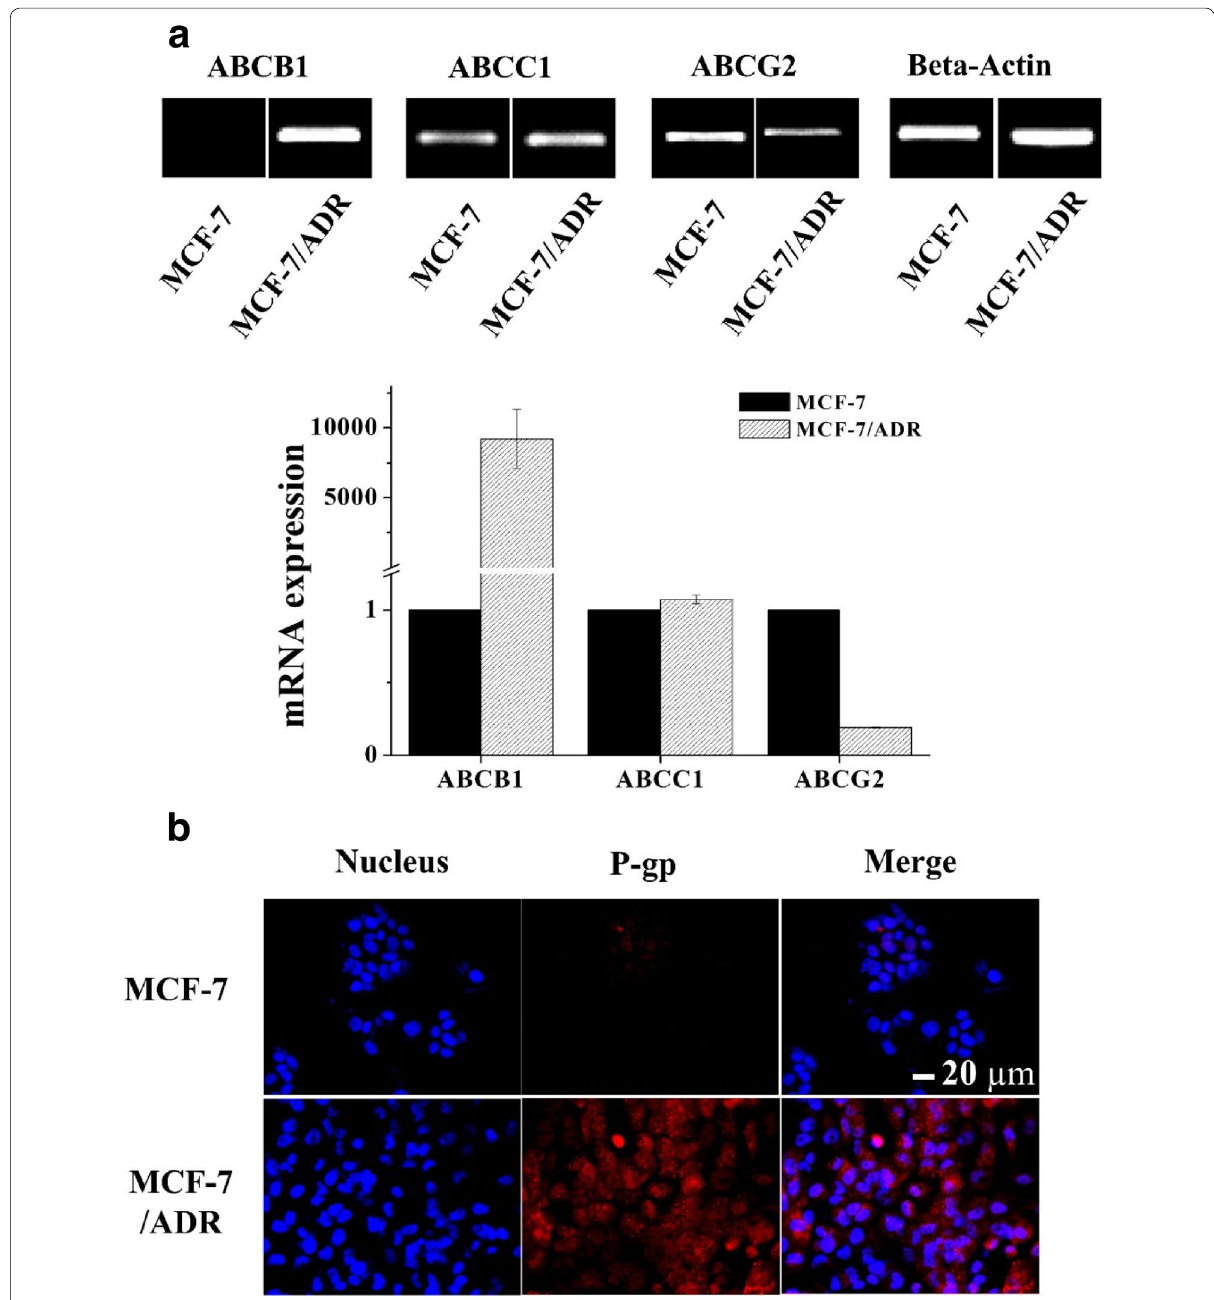
Fig. 2 Confirmation of efflux pump receptor expression in MCF-7/ADR cells. a Qualitative and quantitative mRNA expression analysis of three types of efflux pump receptors in MCF-7 and MCF-7/ADR cells by reverse transcriptase (RT)-PCR and by real-time PCR, respectively. b Immunocytochemical analysis of the expression of P-glycoprotein receptor in MCF-7 and MCF-7/ADR cells (scale bar